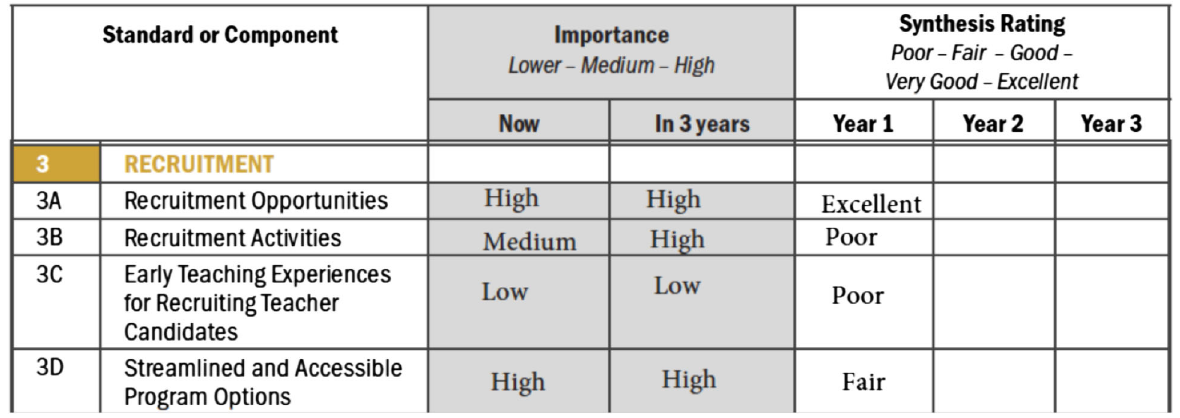
FIG. 4. Example importance and synthesis ratings table, from PTEPA User ’ s